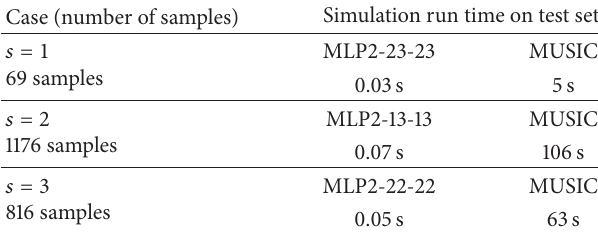
Table 6: Comparison between MLP-DoA 𝑠 and MUSIC models run